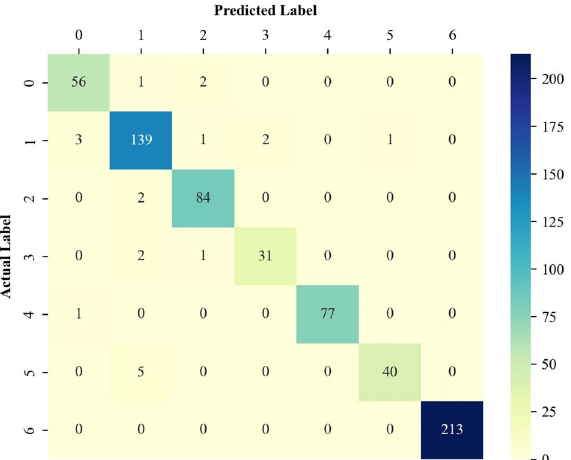
Figure 5. The confusion matrix of the designed model related to the training data classification.